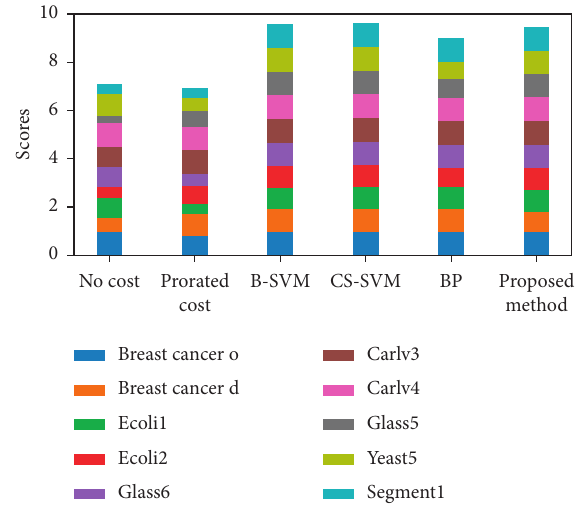
Figure 5: Comparisons of the classification results’ g -means indices.